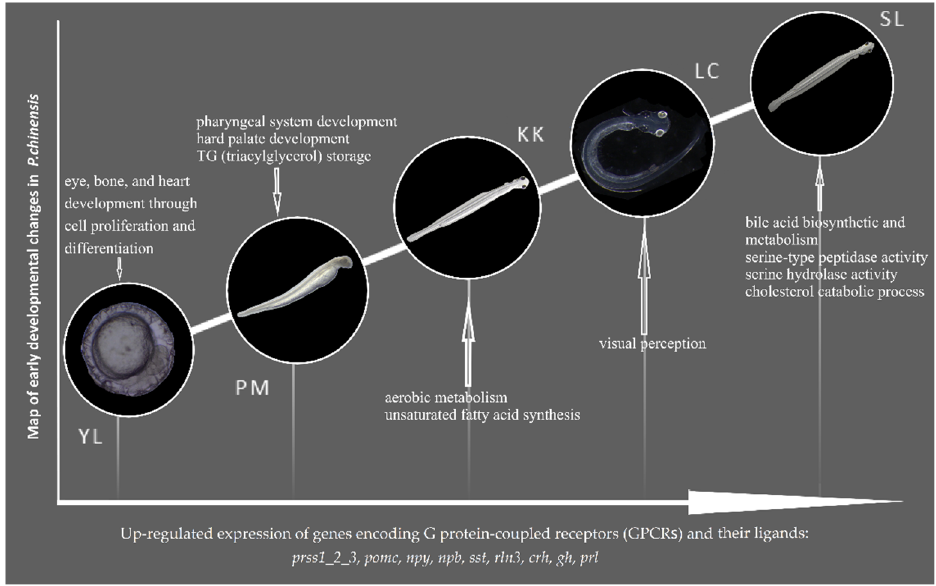
Figure 9. The main changes in biological functions in the early development of clearhead icefish.